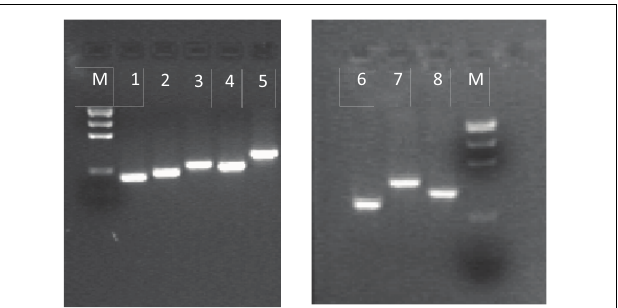
FIGURE 1 | Example of gel electrophoresis pattern of PCR amplicons about some analyzed DRD SNPs with their size. M, Precision Molecular Mass Ruler, Bio-Rad Laboratories, Inc., (size of DNA fragments: 1000, 700, 500, 200, 100 bp). PCR amplicons: 1, DRD 1-A (166 bp); 2, DRD 1-B (187 bp); 3, DRD